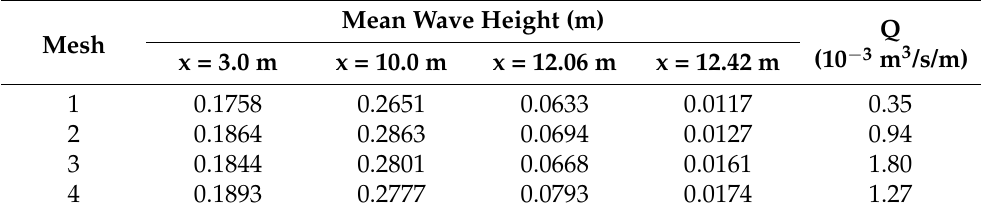
Table 8. Overtopping case: mean wave height at gauges located at x = 3.0, 10.0, 12.06, and 12.42 m and mean overtopping obtained in